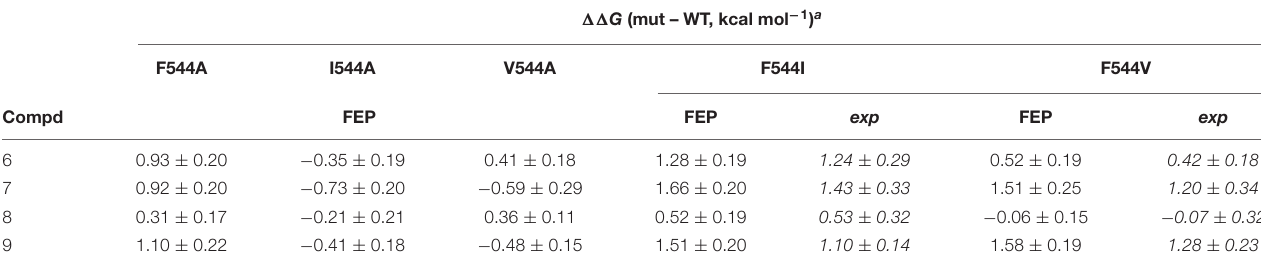
TABLE 4 | Experimental and FEP calculated shifts in binding free energies due to point mutations of IRAP, for the subset of compounds 6–9. (cid:49)(cid:49) G (mut – WT, kcal mol − 1 ) a .